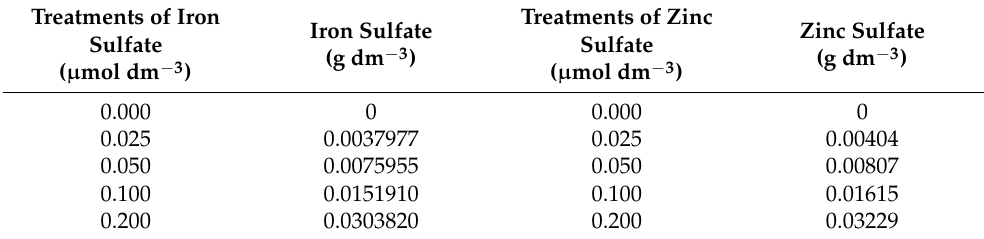
Table 5. Additive formulations established at the experimental